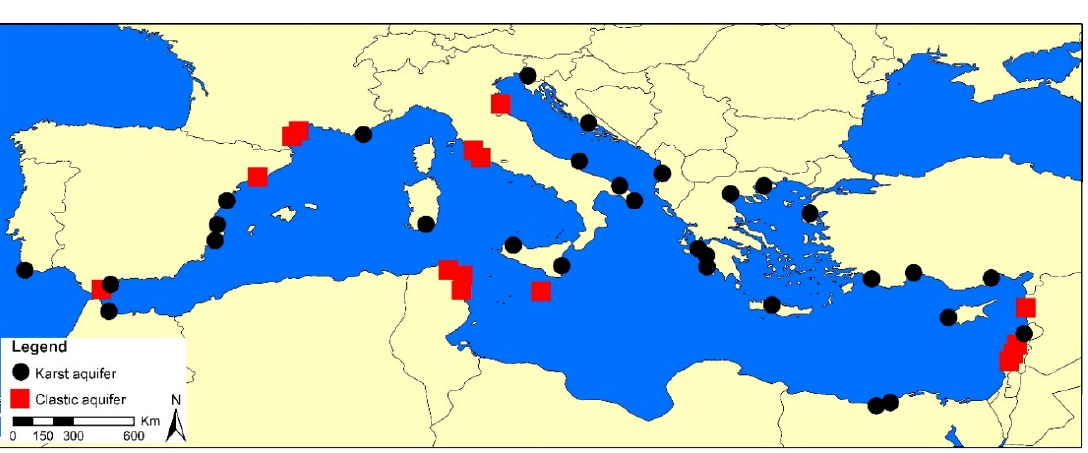
Figure 1. Schematic of the main risks of groundwater degradation.